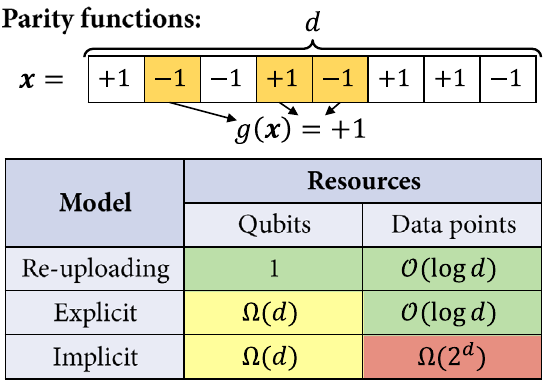
Fig. 5 | Learning separations. We describe a learning task based on parity func- tions acting on d -bit input vectors x ∈ { − 1,1} d , for d 2 N . This task allows us to separate all three quantum models studied in this work in terms of their resource requirements, as a function of d (see Theorem